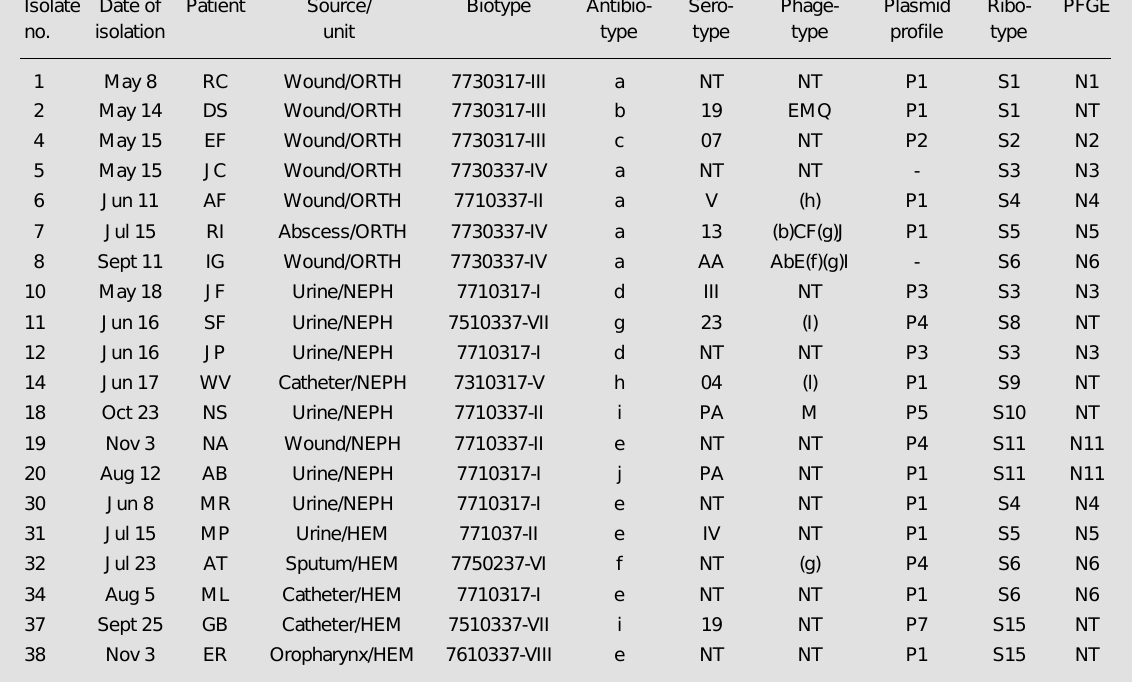
Table 1 - Phenotypic and genotypic characteristics of E. cloacae isolates. ORTH, Orthopedics unit; NEPH, Nephrologic unit; HEM, Hematology unit; NT,